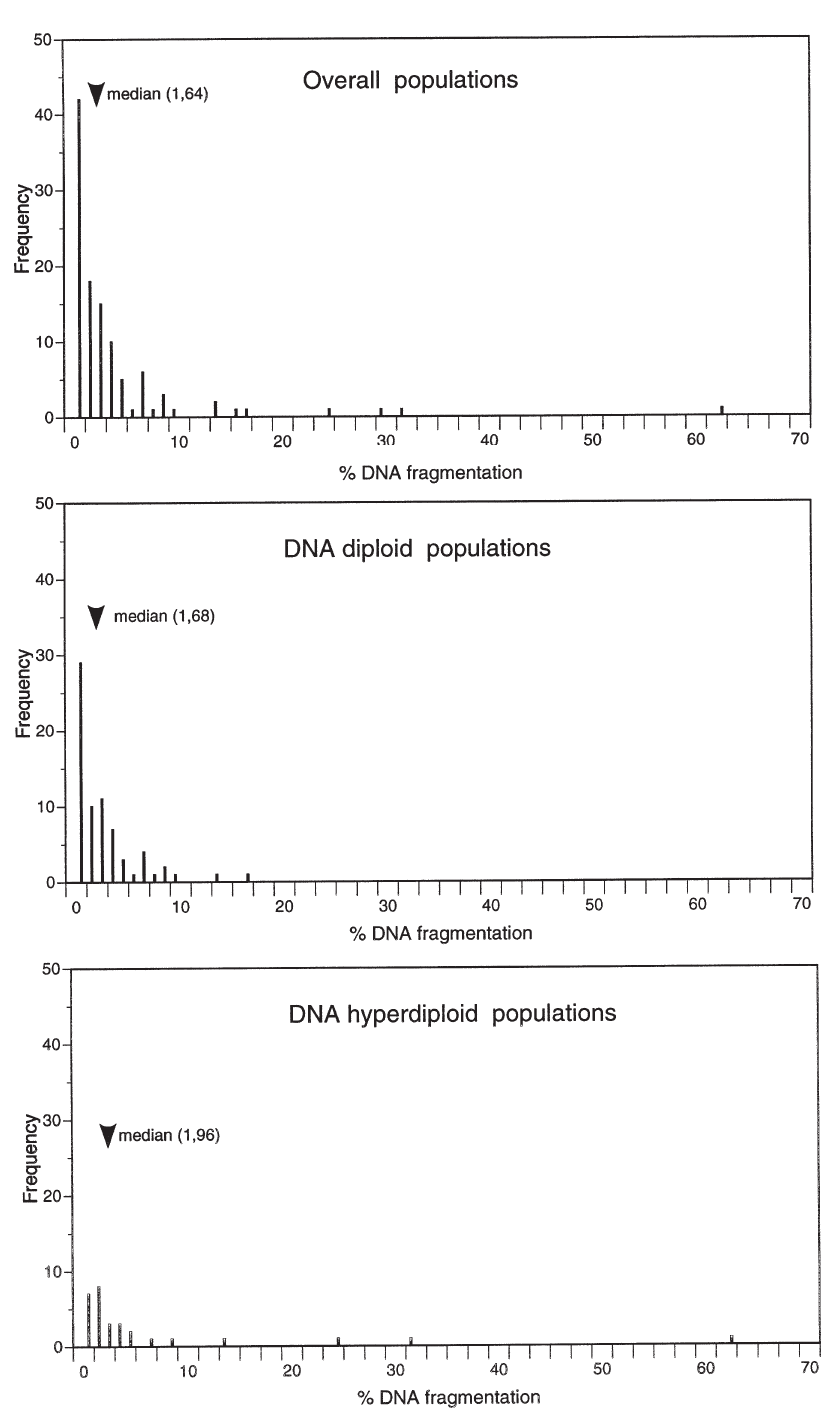
Fig. 2. Frequency distributions of %DNA fragmentation values for 110 samples of breast tumours and for the tumours divided according to the DNA